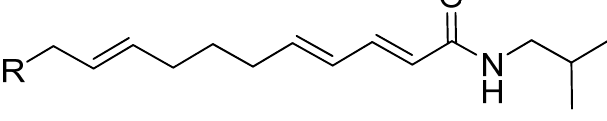
Table 1. Effects of compound 1b – i on the forced swimming test in mice (means ± SEM of eight